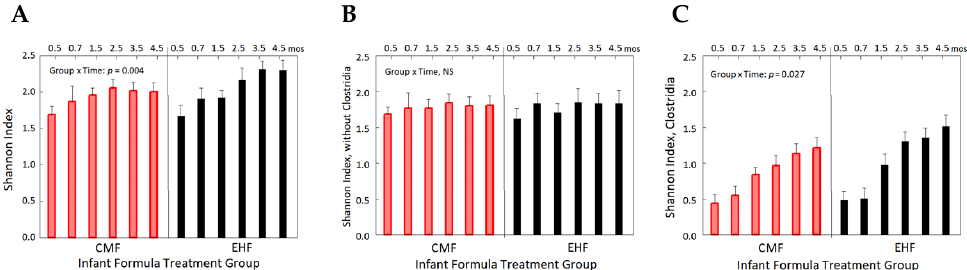
Figure 2. Shannon diversity indexes of ( A ) complete microbial community, ( B ) microbial community without Clostridia, and ( C ) Clostridia only. Red bars depict the CMF (cow milk formula) group and black bars depict the EHF (extensive protein hydrolysate formula) group from 0.5 to 4.5 months (linear mixed-effect modeling).